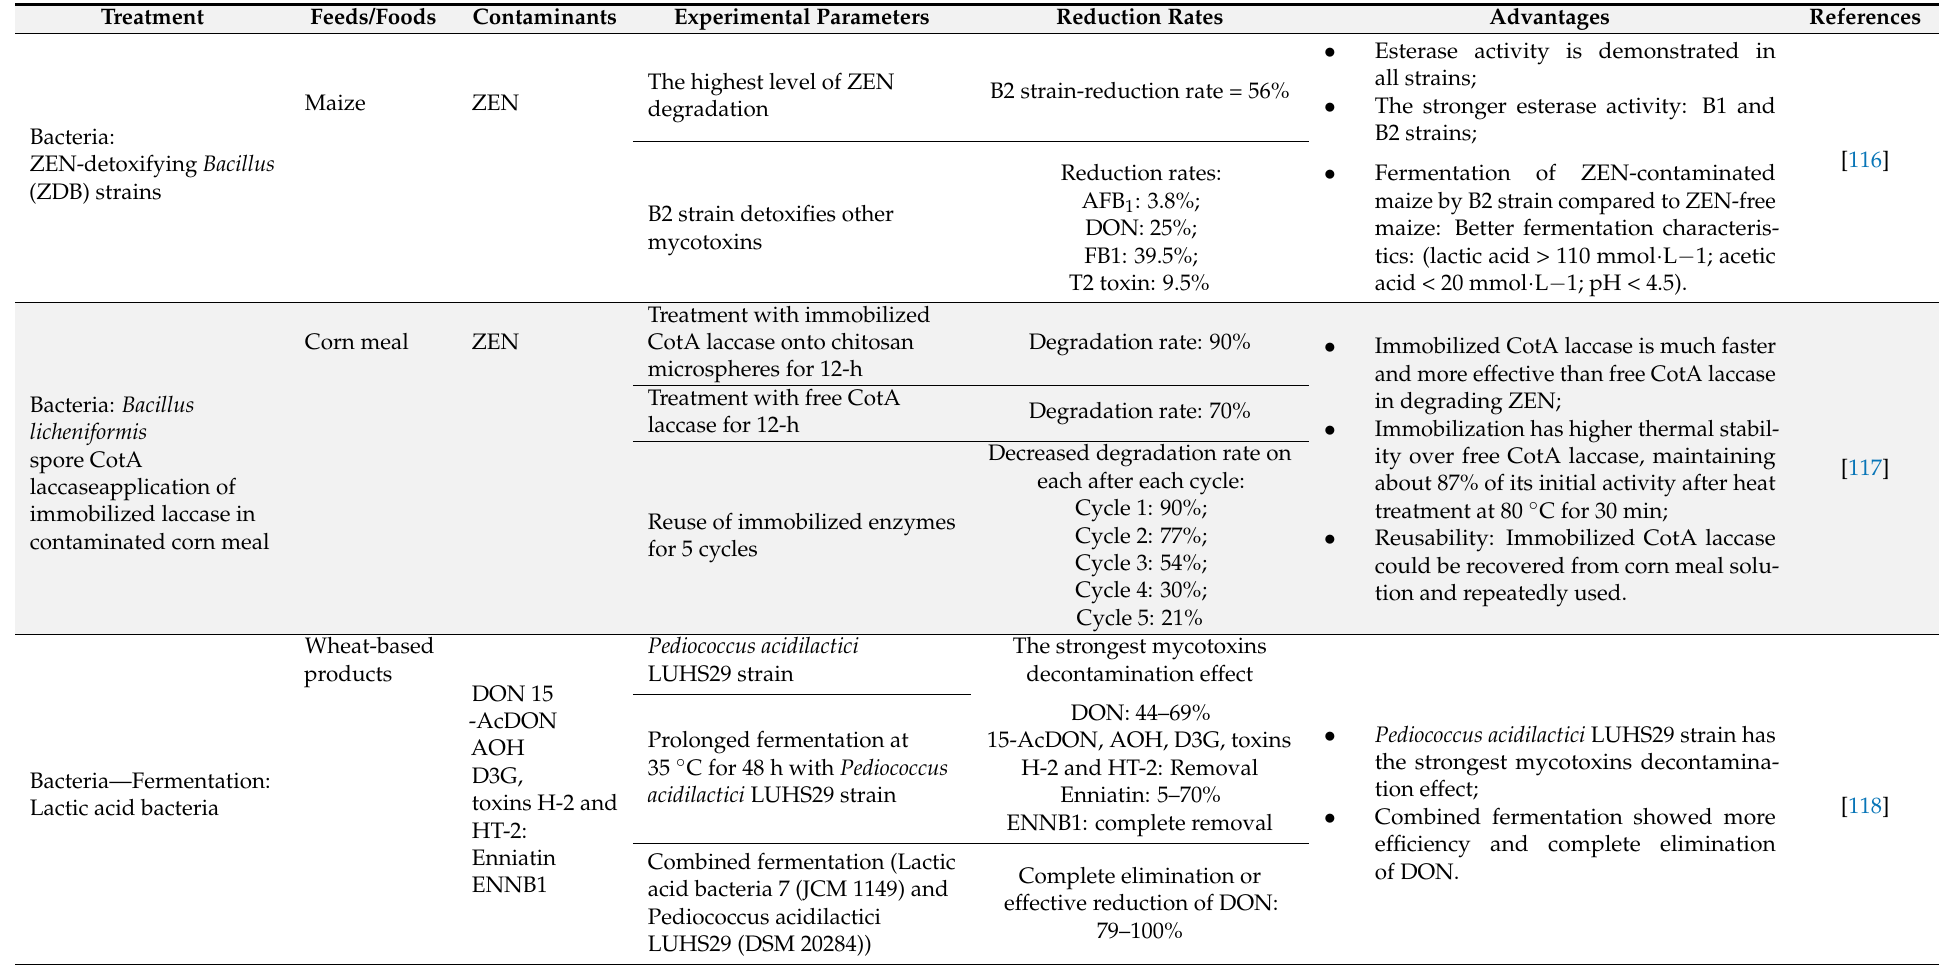
Table 3. Microbial and enzymatic treatments for the reduction of mycotoxins in solid foods and feeds.